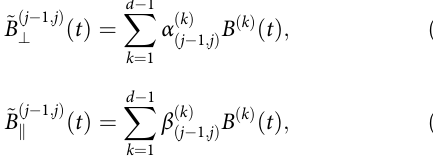
and β ð k Þ can be ð j (cid:2) 1 ; j Þ ð j (cid:2) 1 ; j Þ